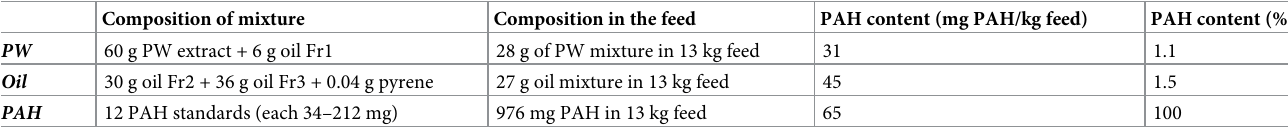
Table 2. Composition of the three PAH sources used in the feed. Composition of mixture Composition in the